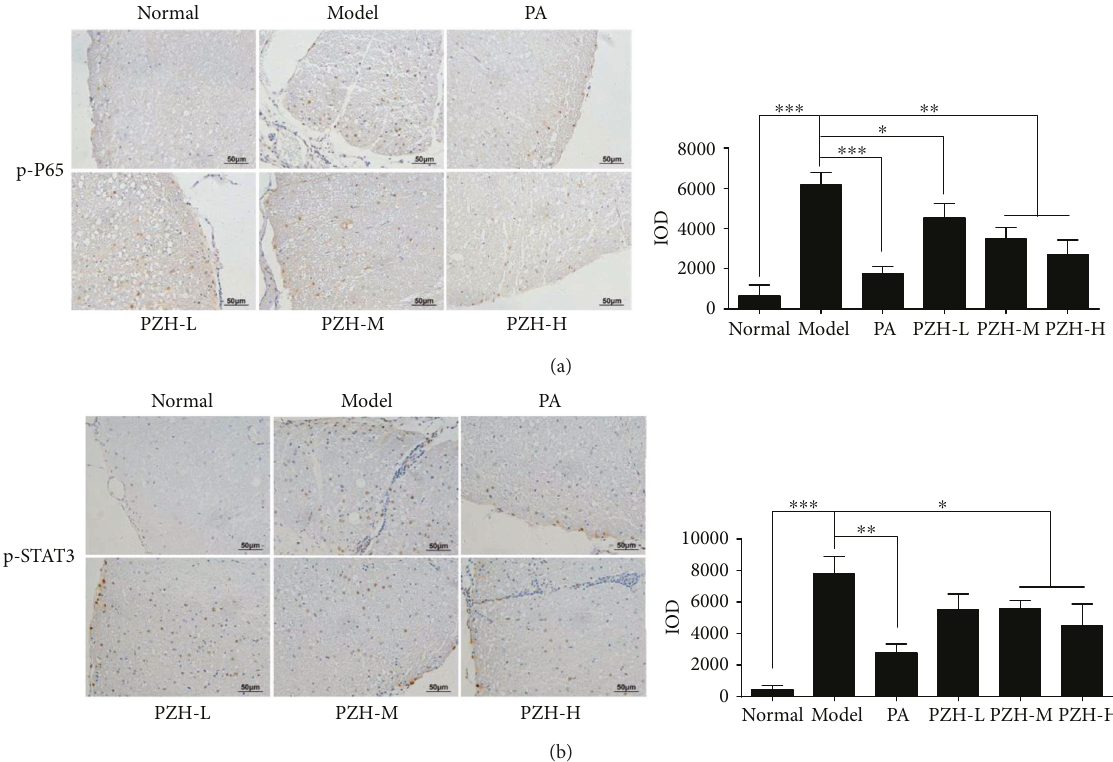
Figure 5: PZH downregulated the levels of p-P65 and p-STAT3 in the CNS of EAE rats. Representative immunohistochemistry images (left) and IOD means (right) of p-P65 (a) and p-STAT3 (b) in the spinal cord of rats from each group. Original magni fi cation 200x. All data were shown as the mean ± SD. ∗ P < 0 05 , ∗∗ P < 0 01 , and ∗∗∗ P < 0 001